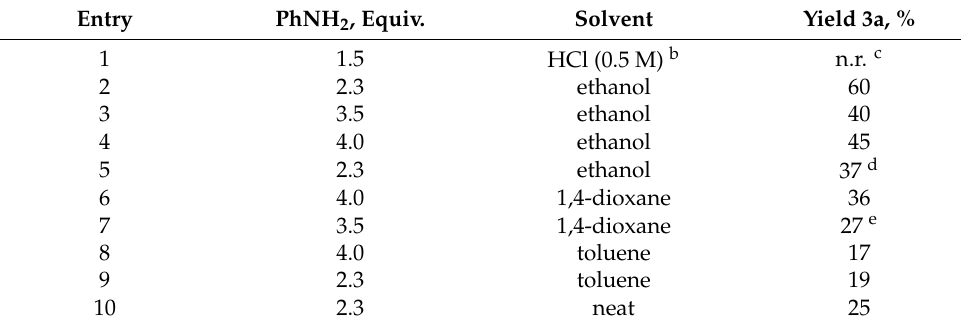
Table 1. Optimization of the reaction conditions of DHA- f 6 with aniline a .